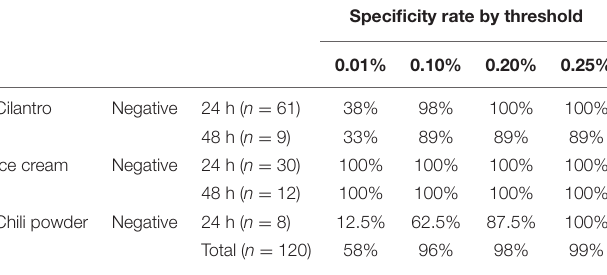
TABLE 3 | Salmonella enterica specificity rates by limit of detection threshold (0.01, 0.10, 0.20, and 0.25%).